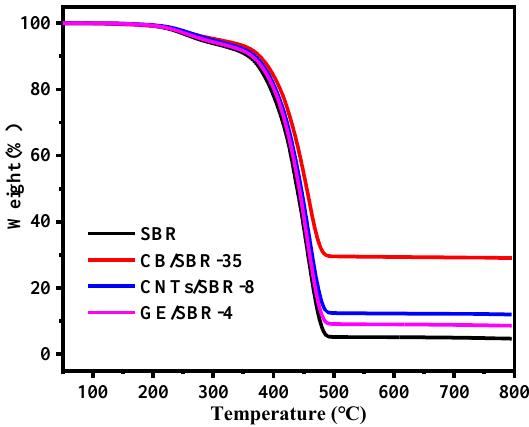
/ SBR-35, CNTs / SBR-8, and GE / Figure 8. TGA curves of SBR, CB/SBR-35, CNTs/SBR-8, and GE/SBR-4. Figure 8. TGA curves of SBR, CB